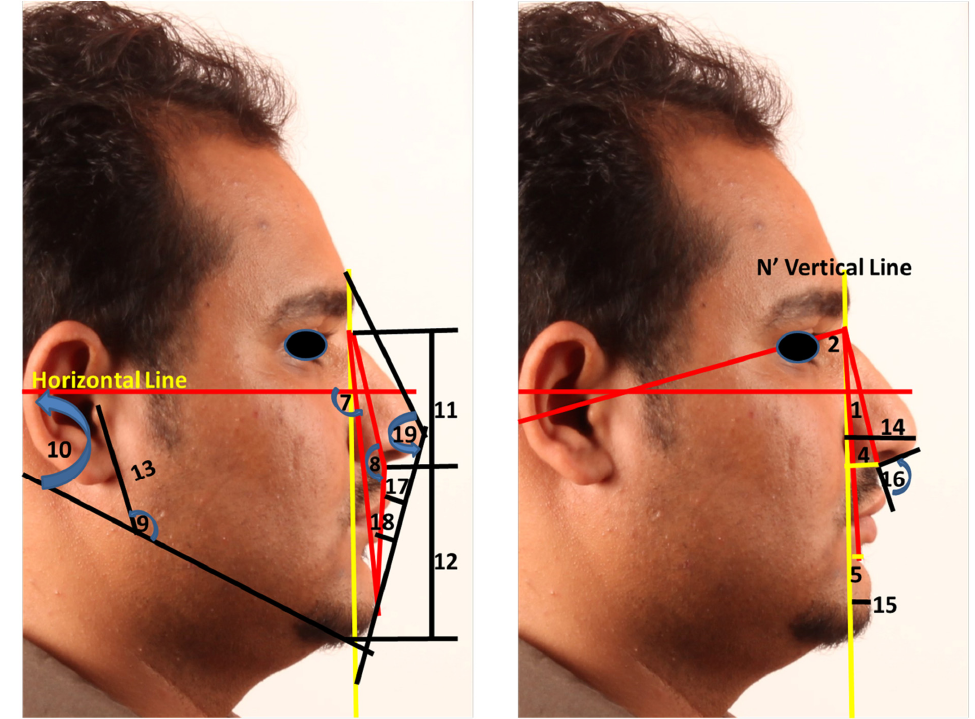
Figure 4. Showing the measurement used in the study as defined in Table 1: ( 1 ) Trg N’ .Sn. (°), ( 2 ) Trg N’ .B’ (°), ( 3 ) the difference between 1 and 2, ( 4 ) N’ Vertical Sn (mm), ( 5 ) N’ Vertical B’ (mm), ( 6 ) the difference between 5 and 6, ( 7 ) N’ Pog’/TH (°), ( 8 ) N’.Sn.Pog’ (°), ( 9 ) Trg. Go’.Me’ (°), ( 10 ) TH-MA (°), ( 11 ) AFH (N’-Me’) (mm), ( 12 ) LAFH (Sn-Me) (mm), ( 13 ) PFH (Trg-Go) (mm), ( 14 ) Pn-N’ Vertical (mm), ( 15 ) Pog’-N Vert (mm), ( 16 ) NLA (°), ( 17 ) Ls/E line (mm), ( 18 ) Li/E line (mm), and ( 19 ) Gb.Pn.Pog’ (°).